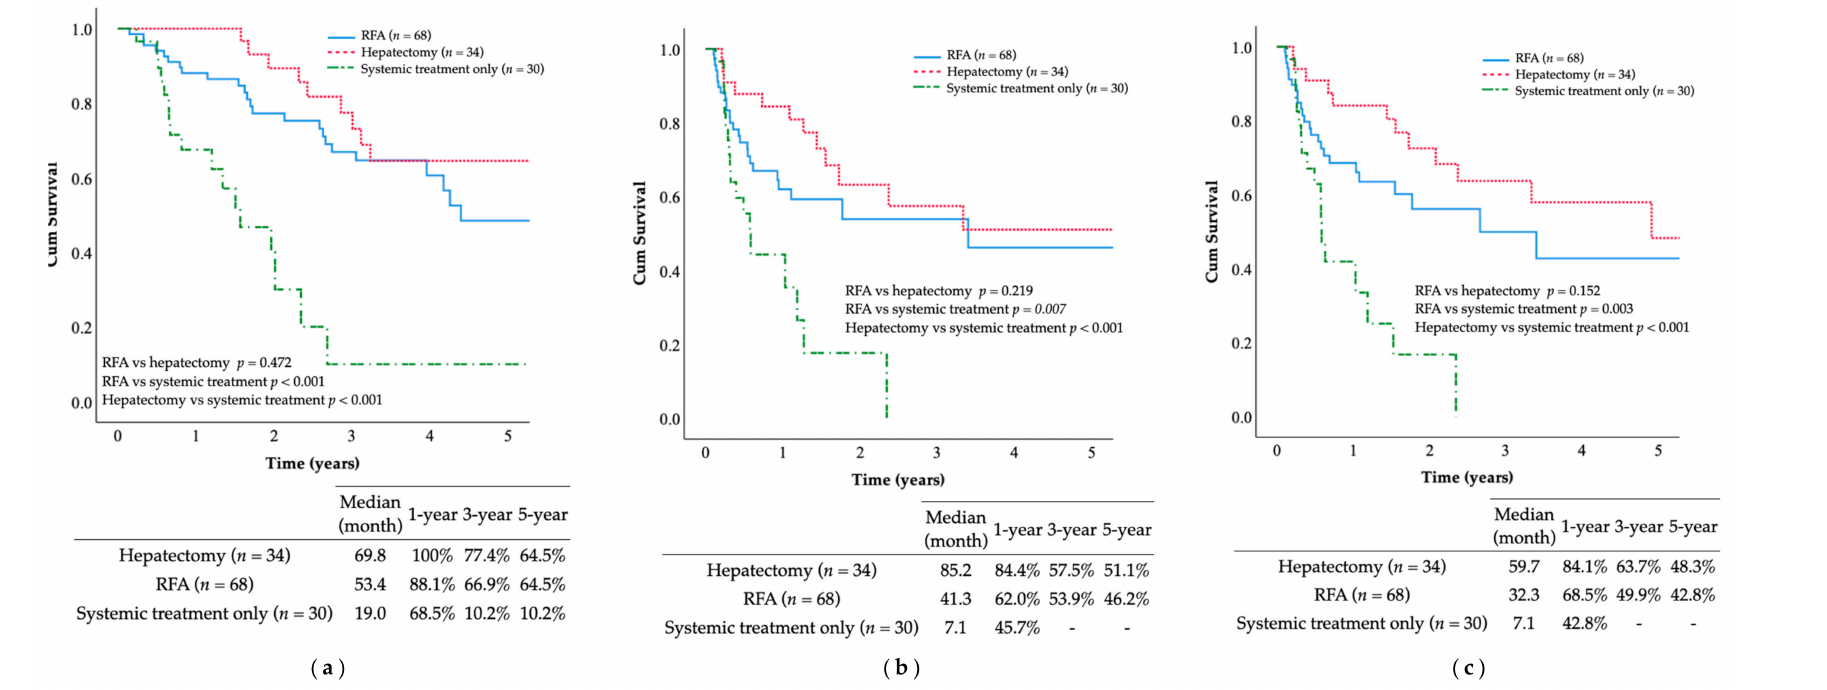
Figure 3. ( a ) The OS rates of the multi-RFA and hepatectomy groups were not significantly different and were superior to that of the systemic treatment only group ( p < 0.001); ( b ) the RFS rates of the multi-RFA and hepatectomy groups were not significantly different and were superior to that of the systemic treatment only group ( p = 0.007); ( c ) the IHRFS rates of the multi-RFA and hepatectomy groups were not significantly different and were superior to that of the systemic treatment only group ( p =